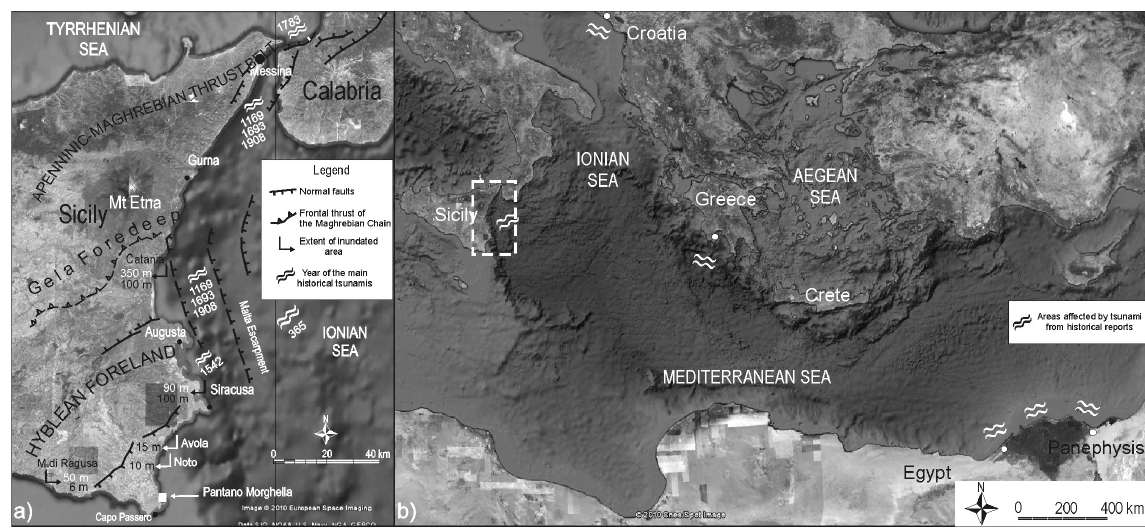
Fig. 1. (a) Google Earth map of Eastern Sicily showing the main structural domains and seismotectonic features (after Monaco et al., 2005); the wavy symbols with numbers indicate the year and affected areas of the main historical tsunamis affecting the eastern coast of Sicily; extent of inundated areas: white data for the 1693 tsunami and black for the 1908 tsunami (modified from Gerardi et al., 2008); (b) Google Earth map with localities affected by the 365 Crete tsunami according to historical information (after Guidoboni et al., 1994). Please note that the wavy symbols indicate generic areas affected by tsunamis from historical